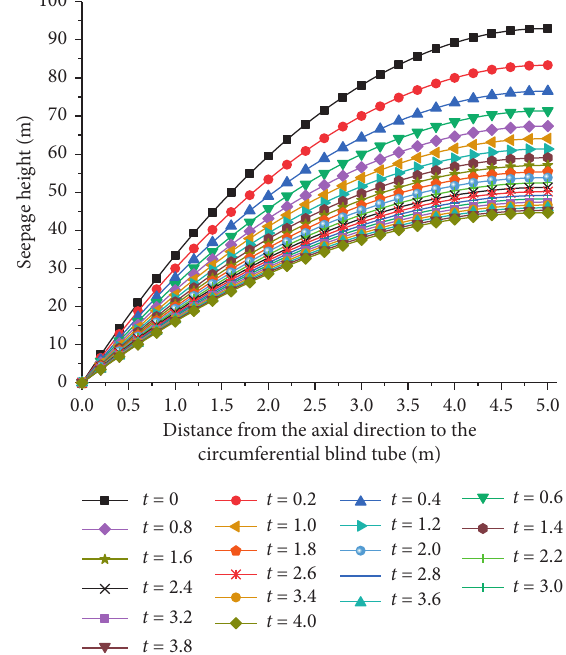
Figure 5: Relationship between the grouting circle thickness and the water head.